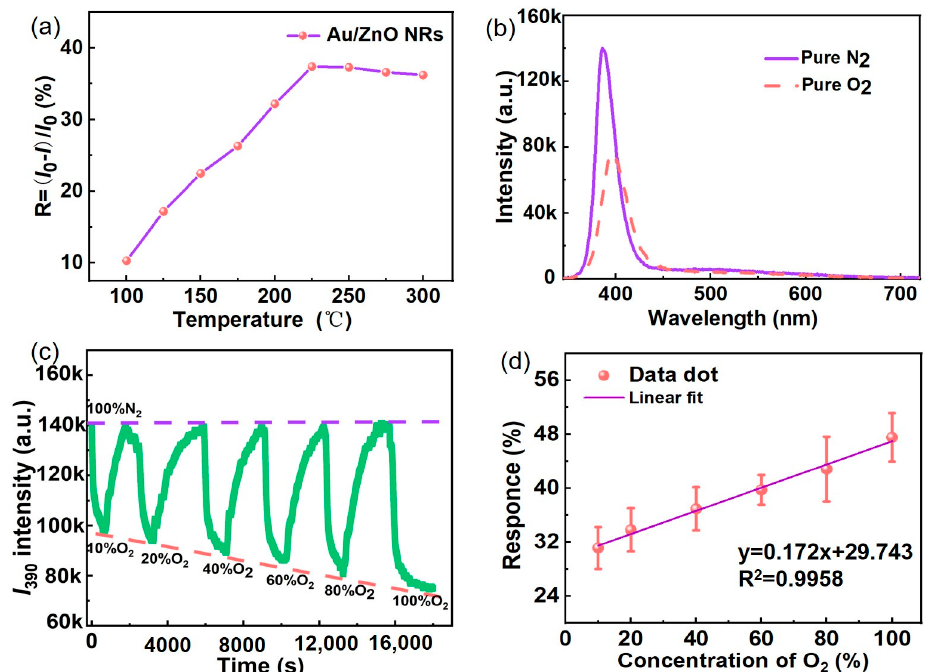
Figure 6. ( a ) Responses of Au/ZnO NRs with exposure to 20% oxygen atmosphere at temperatures ranging from 100–300 ◦ C. ( b ) PL spectra of Au/ZnO NRs measured in pure nitrogen and oxygen atmospheres. ( c ) Dynamic response of Au/ZnO NRs with exposure to 10–100% oxygen atmospheres at 225 ◦ C. ( d ) Fitting line of responses of Au/ZnO NRs with exposure to 10–100% oxygen atmospheres.